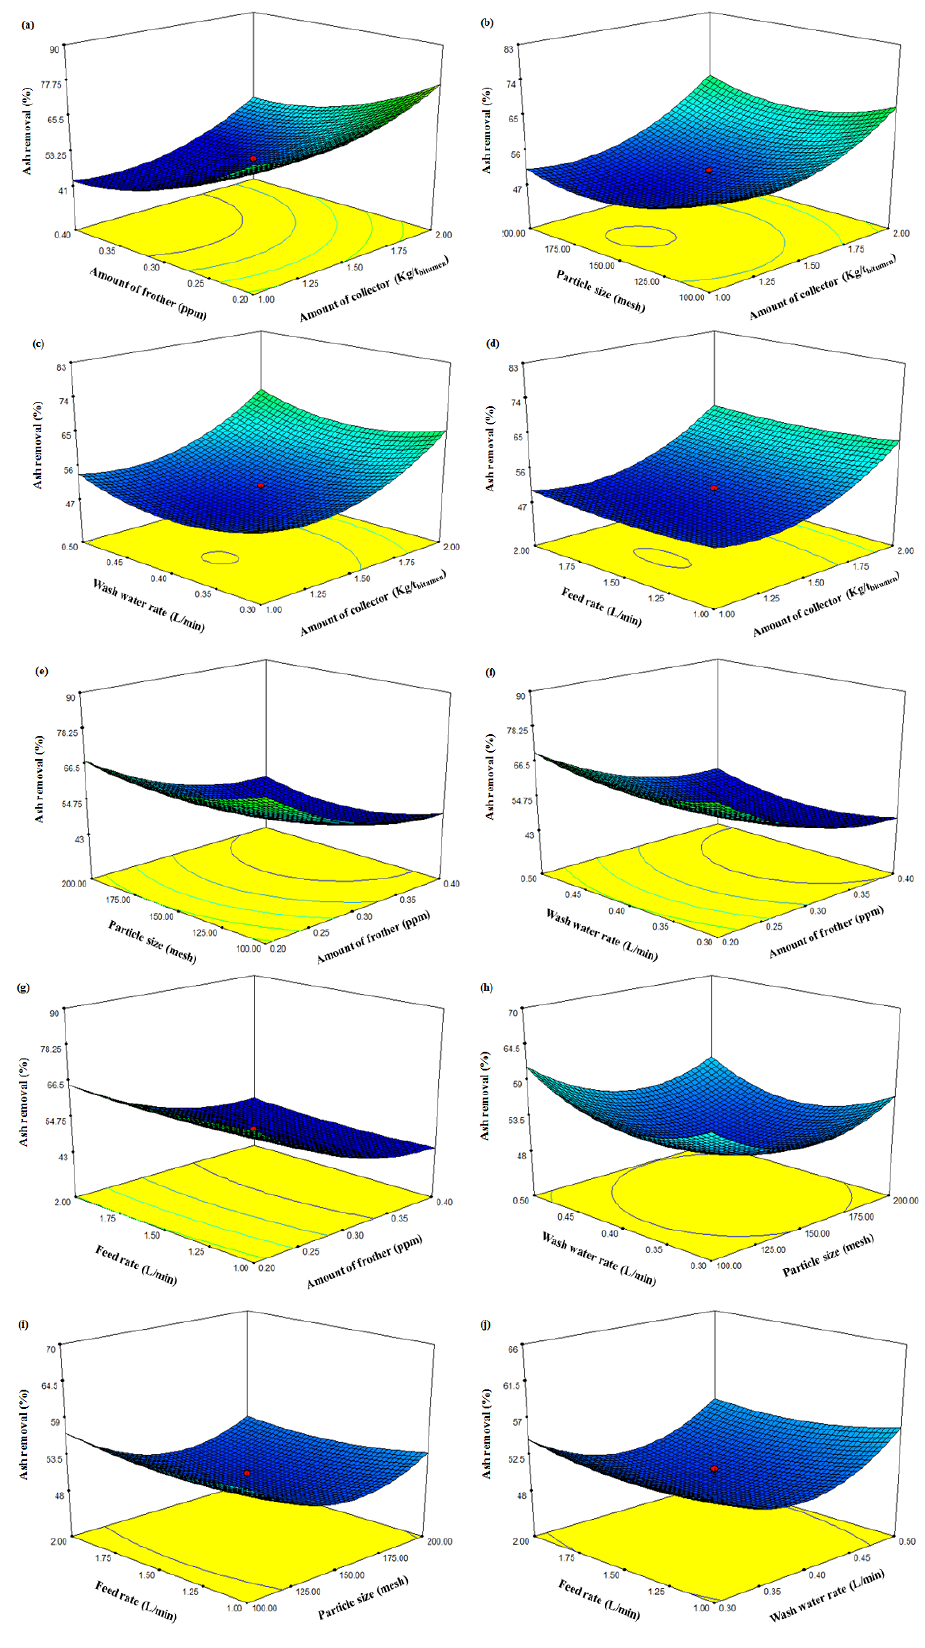
Fig. 4. Response surface plot for ash removal